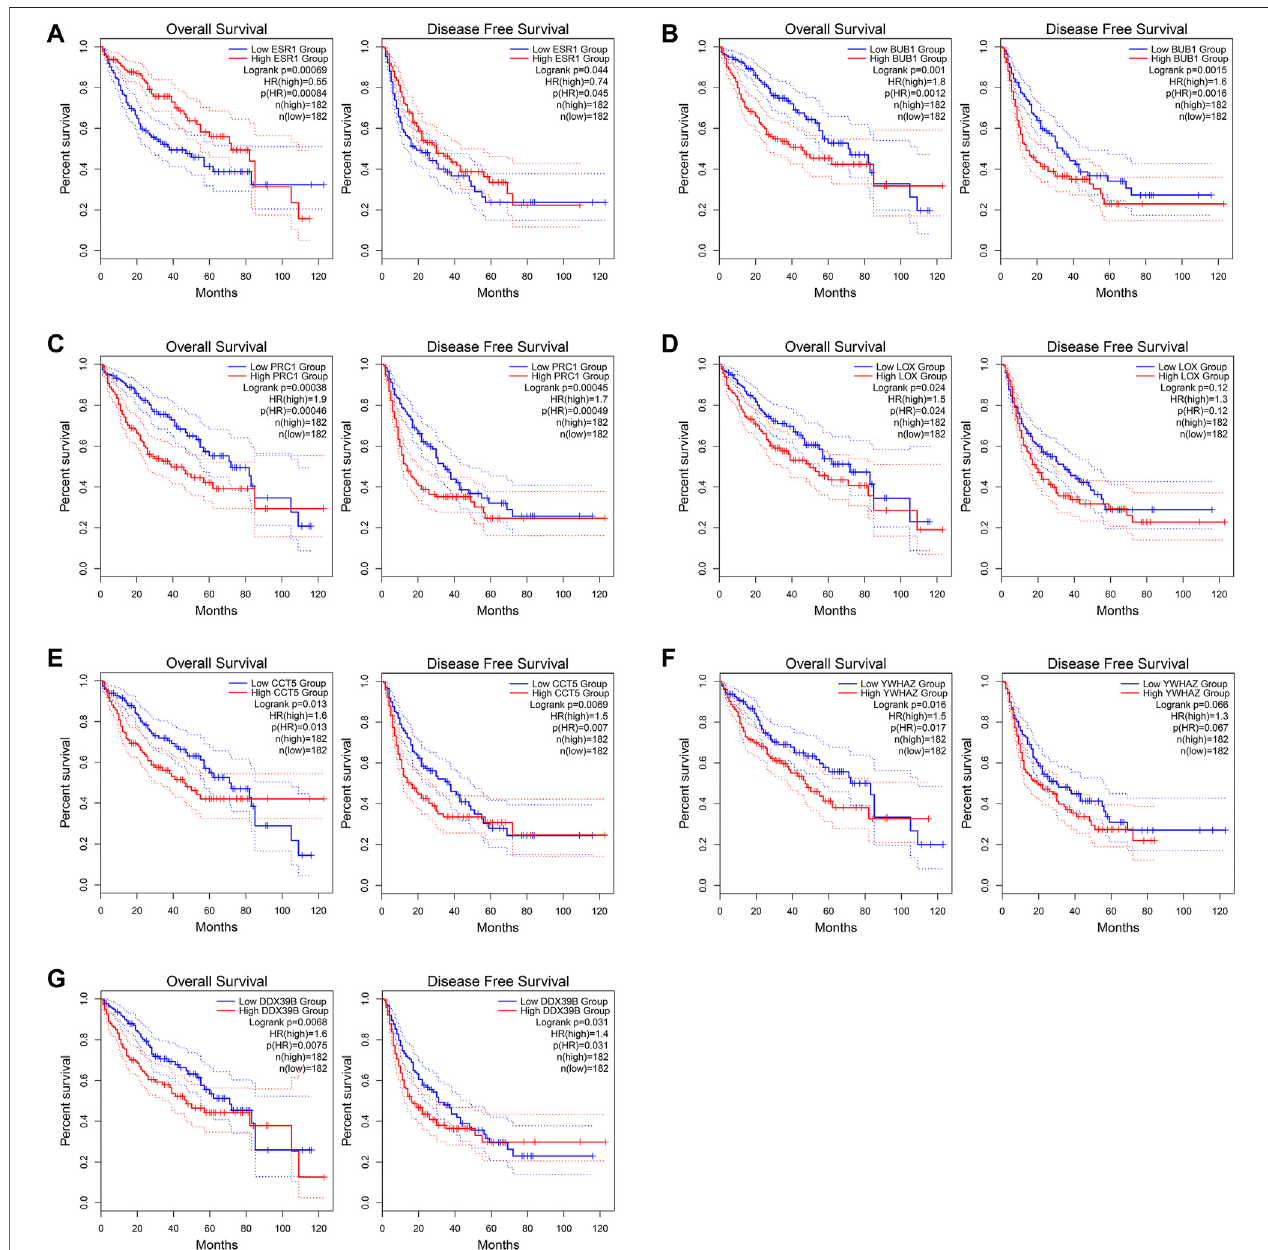
FIGURE 10 | Overall survival (OS) and disease-free survival (DFS) analyses of the seven core genes using the GEPIA2 (http://gepia2.cancer-pku.cn/#index) online tool. (A) ESR1 . (B) BUB1 . (C) PRC1 . (D) LOX . (E) CCT5 . (F) YWHAZ . (G) DDX39B .